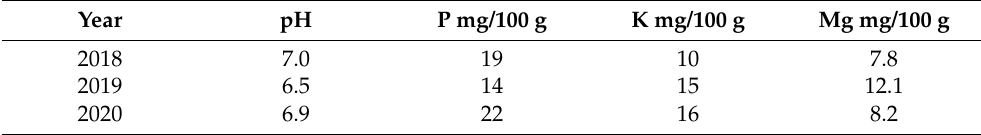
Table 2. Summary of physical and chemical soil properties of the experimental site for the top 30 cm in experimental